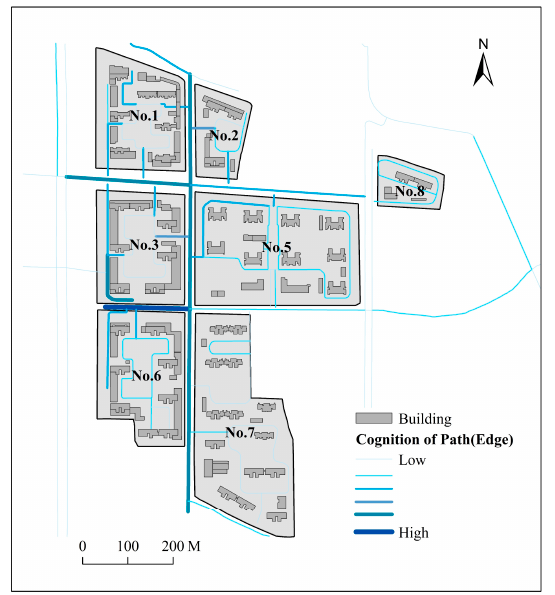
Figure 9. The cognitive results of the path (edge) elements.